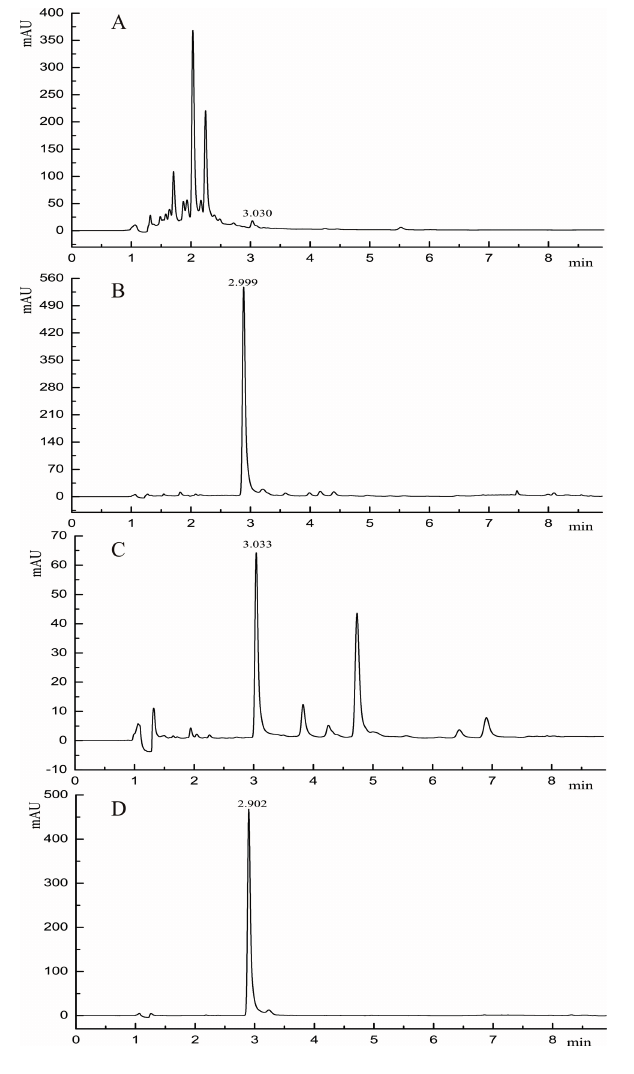
Figure 3. UPLC chromatograms of three eluction fractions and purified sample: ( A ) fraction 5:5; ( B ) fraction 4:6; ( C ) fraction 3:7; ( D ) purified